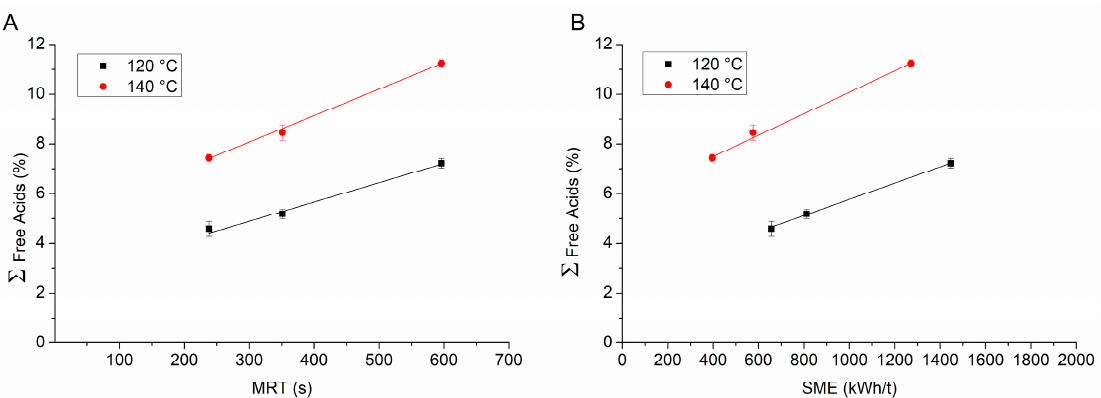
Figure 5. Plot of the sum of free acids against mean residence time (MRT) ( A ) and specific mechanical energy (SME) ( B ).